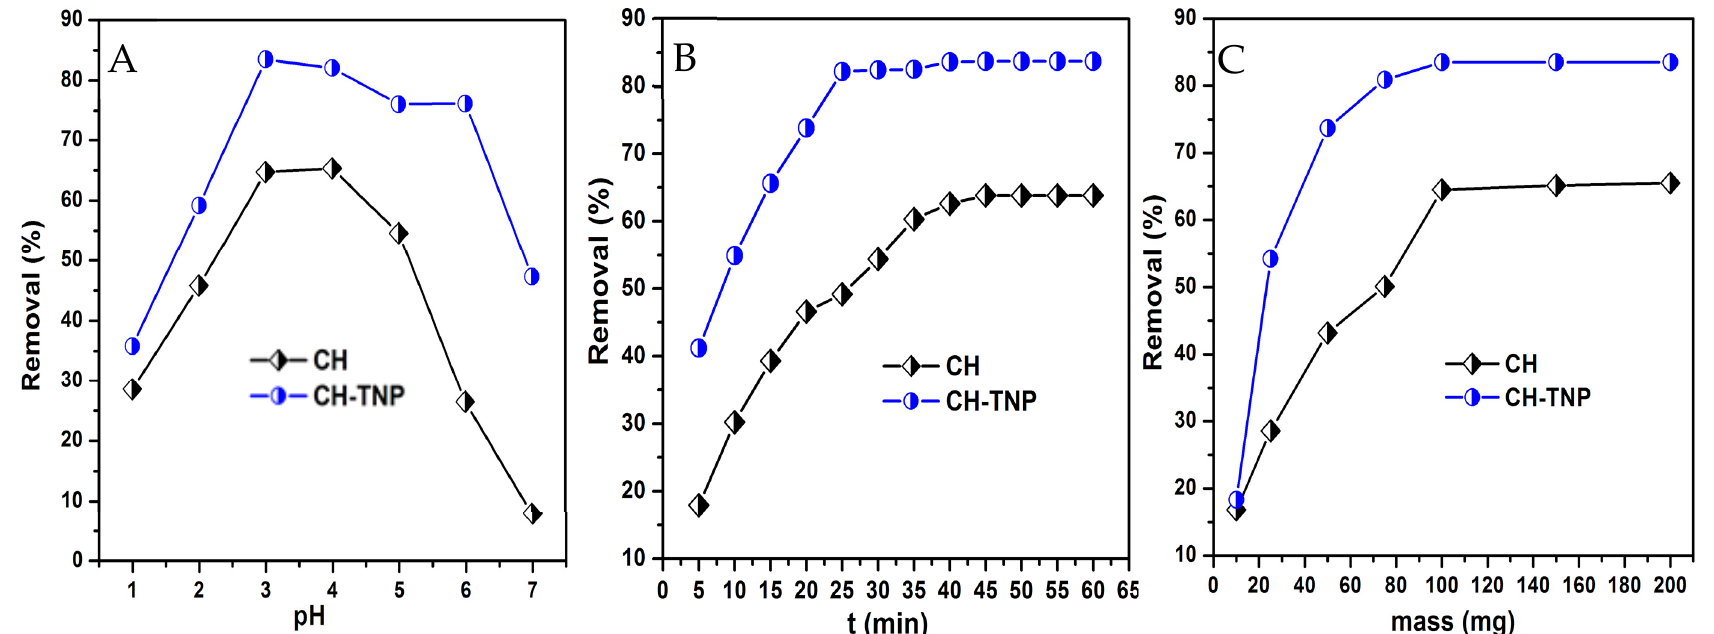
Figure 4. pH ( A ), contact time ( B ), and dose ( C ) studies plots for the adsorption of Cu(II) on CH and CH-TNP.